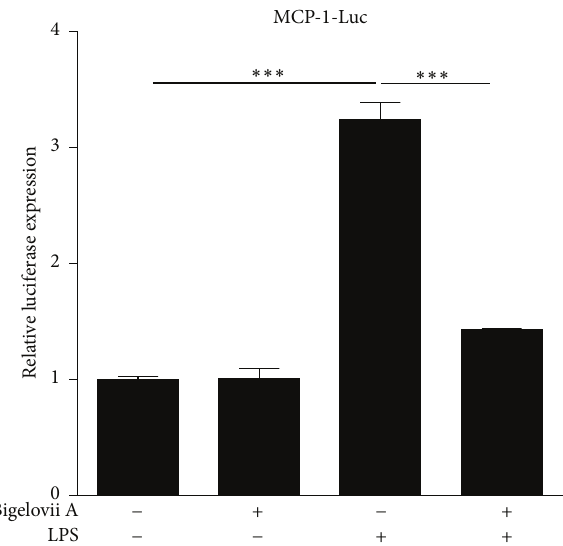
Figure 5: Effect of Bigelovii A on MCP-1 promoter-driven luciferase expression during LPS-induced inflammation in MH-S cells. MH-S cells were transiently transfected with total of 0.5 𝜇 g indicated plasmids. 48h after transfection, the cells were pretreated with or without 10 𝜇 M of Bigelovii A for 1h, followed by treatment with PBS or 100ng/mL of LPS. 4h later, the cells were lysed, and luciferase activity was measured. Luminometer values were normalized for expression from a cotransfected pRL-TK gene and negative control sequentially. Results are reflected by means ± SEM ( 𝑛 = 3 ). ∗∗∗ indicated statistically significant difference— 𝑝 < 0.001 . Negative control: cells treated by Vehicle plus PBS. Positive control: cells receiving LPS plus Vehicle